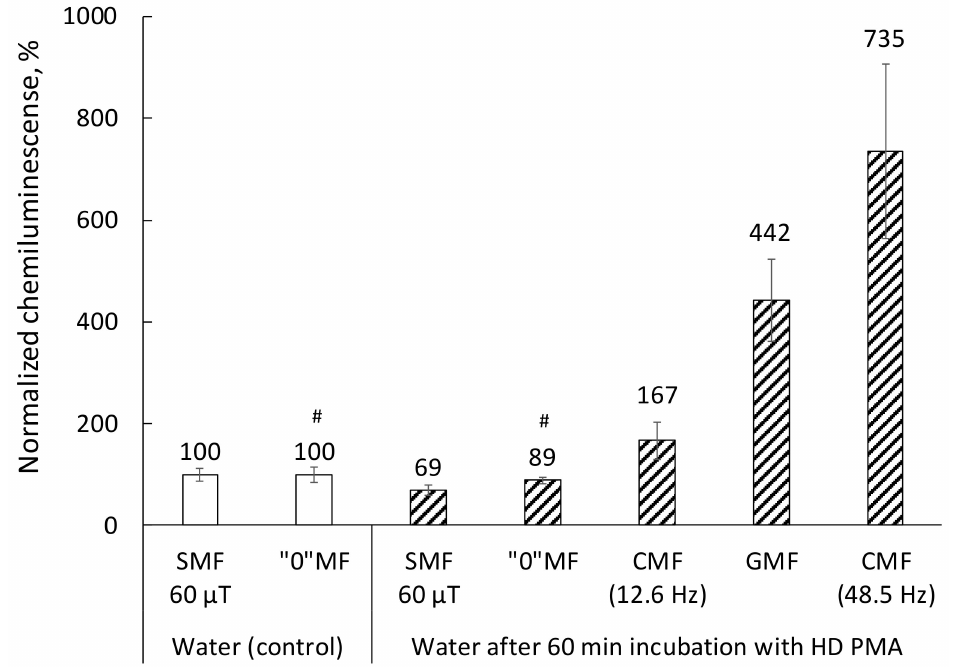
Figure 6. Maximum chemiluminescence intensity in a suspension of neutrophils after the addition of water preincubated with HD PMA in different magnetic fields. The samples contained: suspension of neutrophils—2.5 × 10 5 cells; water sample incubated for 0 min (empty bar) and 60 min (hatched bar) at: SMF (60 µ T), “0”MF (“magnetic vacuum” ~<20 nT), CMF (12.6 Hz)—combination of static (60 µ T) and alternating magnetic field (100 nT), which is formed according to the sinusoidal regime at 12.6 Hz, CMF (48.5 Hz)—combination of SMF (60 µ T) and AMF (100 nT), which is formed according to the sinusoidal regime at 48.5 Hz, GMP—outside the controlled magnetic field generating device; fMLF (2 µ M); luminol (0.35 mM). The acceptor (water) accounted for 80% of the total volume of the sample. Measurements were performed at 37 ◦ C and pH 7.4. For all pairwise comparisons within the group “Water after 60 min incubation with HD PMA” p < 0.05; for all comparisons of corresponding samples between groups “Water after 60 min incubation with HD PMA” and “Water (control)” p < 0.05 (except samples which were incubated in “0” MF. For these # p >